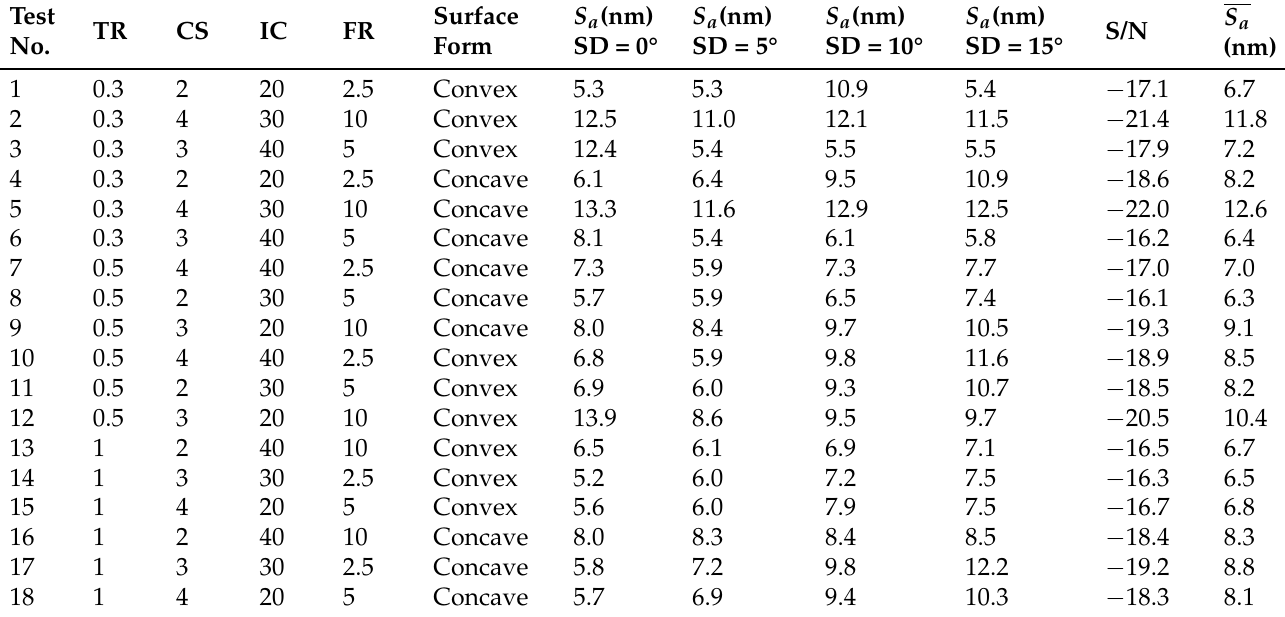
Table 2. Surface roughness of the machined spherical